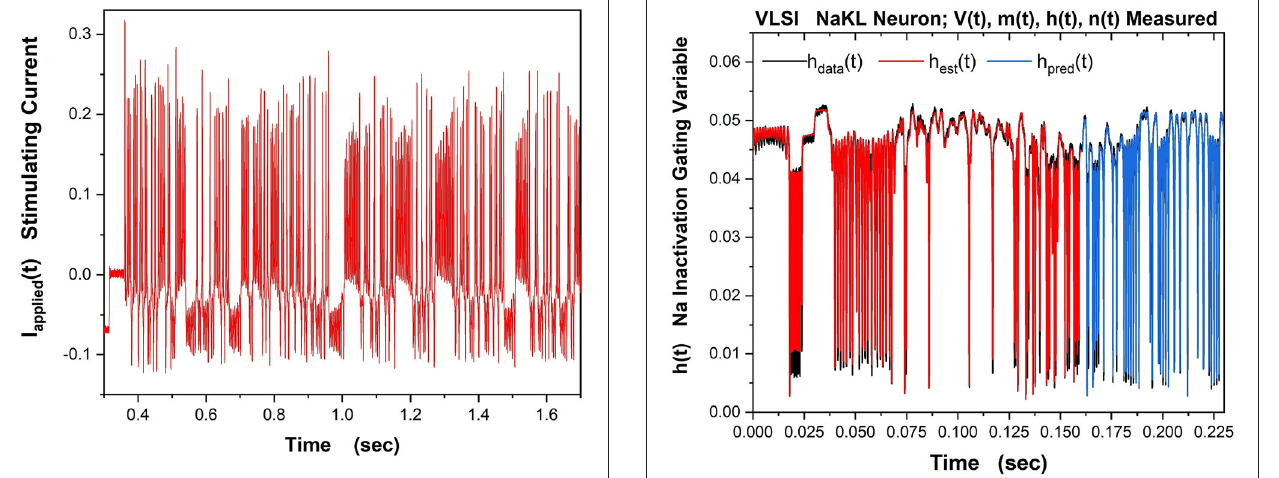
FIGURE 10 | The NaKL VLSI neuron was driven by the waveform for I injected ( t ) V ( t ), m ( t ), h ( t ), n ( t ) seen in Figure 8 . The four state variables for the NaKL { } model were recorded and used in an SDA “nudging” protocol to estimate the parameters of the model actually realized at the manufacturing facility. Here we h data ( t ), h est ( t ), h pred ( t ) display the Na inactivation variable h ( t ): –the observed { } h ( t ) time course when I injected ( t ) was used, the estimated h ( t ) time course using SDA, and finally the predicted h ( t ) time course from the calibrated model actually on the VLSI chip. In a laboratory experiment, this attribute of a neuron would be unobservable. Note we have rescaled the gating variable from its h ( t ) natural range 0 1) to the range within the VLSI chip. The message of ≤ ≤ this Figure is in the very good accuracy and prediction of an experimentally unobservable time